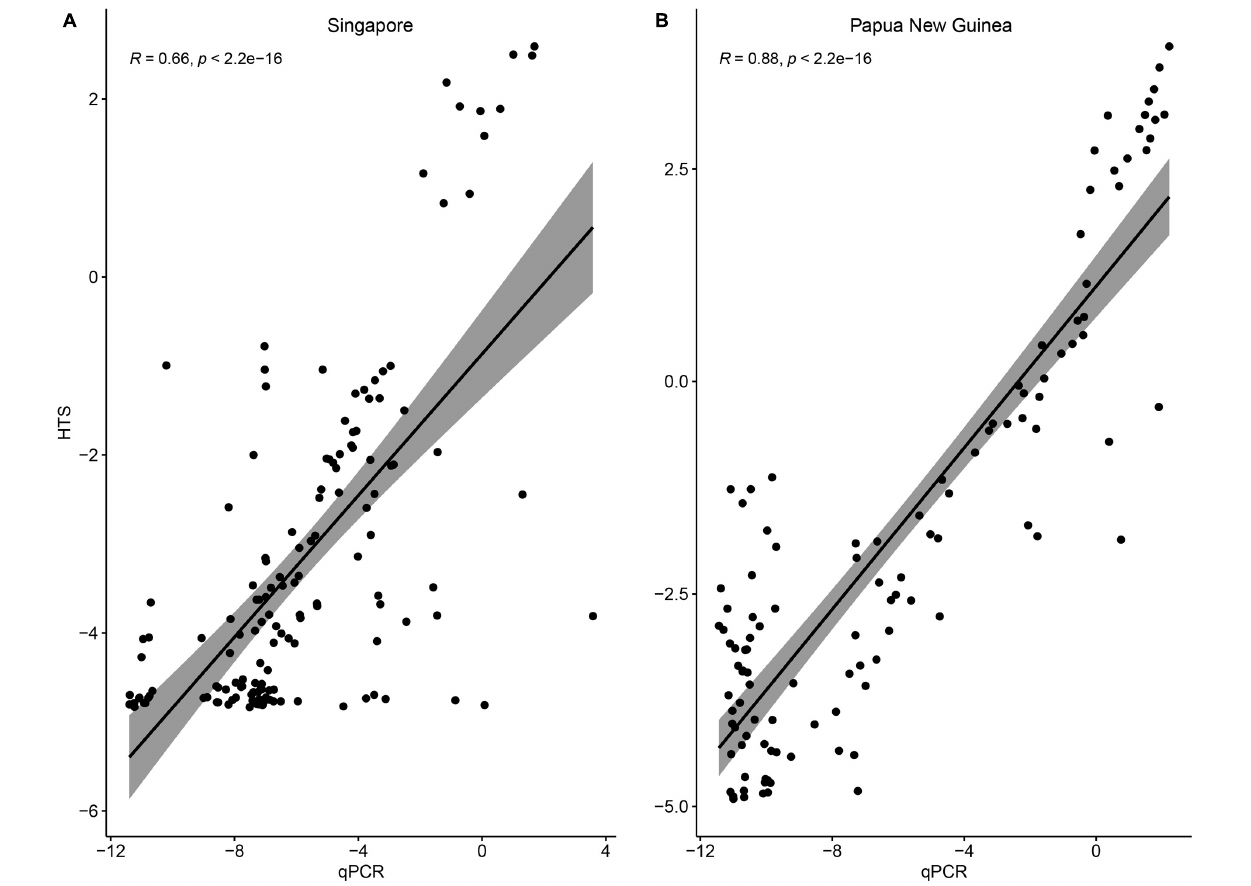
FIGURE 3 | Relationship between the log-transformed relative abundances of Durusdinium vs. Cladocopium ITS1 concentrations (quantitative polymerase chain reaction) and ITS2 read abundances (high-throughput sequencing) on a sample level among colonies from (A) Singapore and (B) Papua New